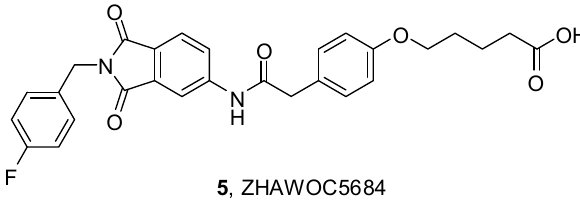
Figure 3. Previously identified potent and selective MMP-13 inhibitor.